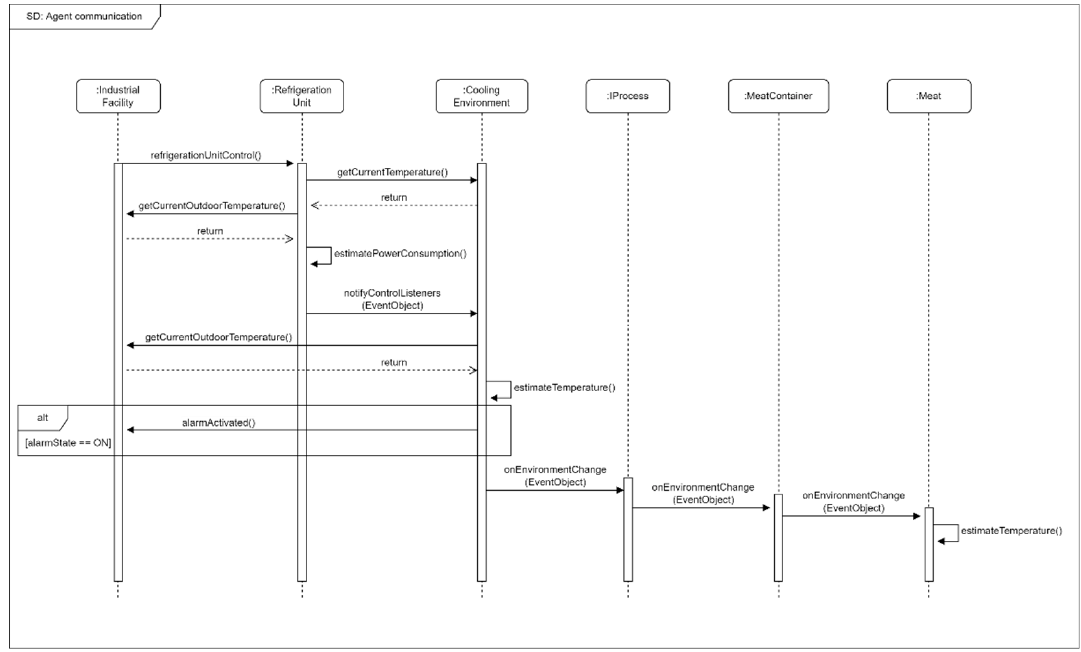
Figure 2. Sequence diagram showing primary-agent communication and interaction.